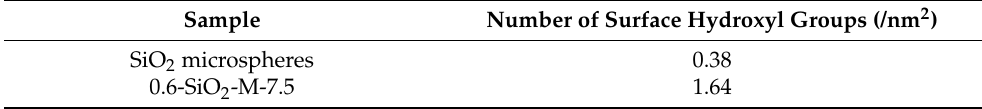
Table 1. Number of surface hydroxyl groups of SiO 2 microspheres before and after